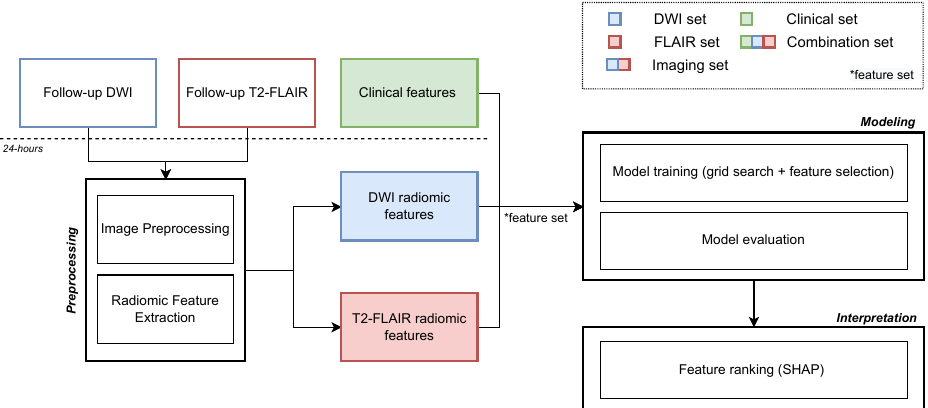
Figure 1. Schematic representation of the study workflow. Follow-up DWI and T2-FLAIR scans are preprocessed and radiomic features are extracted from the segmented lesions. Five different sets of features are then used to train an ensemble tree-based ML classifier to predict binary 90-day mRS (0–2 vs. 3–6). Each set respectively includes: (1) only DWI radiomic features ( DWI set ), (2) only T2-FLAIR radiomic features ( FLAIR set ), (3) both DWI and T2-FLAIR radiomic features ( imaging set ), (4) only clinical characteristics ( clinical set ), and (5) a combination of all the radiomic features and the clinical characteristics available up to 24 h ( combination set ). Finally, the models’ interpretability is evaluated using SHapley Additive exPlanations